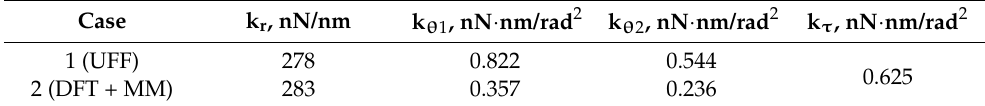
Table 1. k r , k θ and k τ force field constants for InN nanostructures.